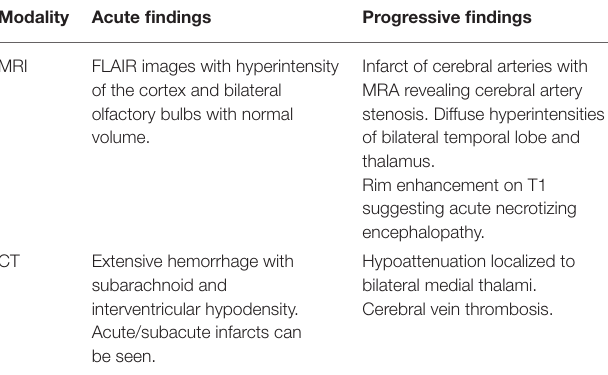
TABLE 3 | Neurovascular imaging features of